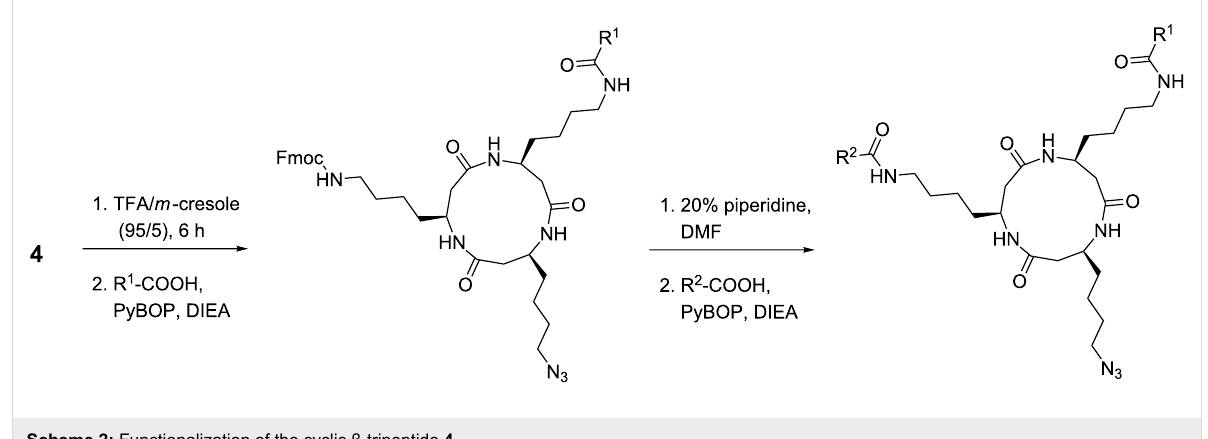
a specific hydrogen-bonding network orthogonal to the peptide ring aggregation, which will be of value for aggregate forma- tion and molecular architectures defined by a three-dimensional network of hydrogen